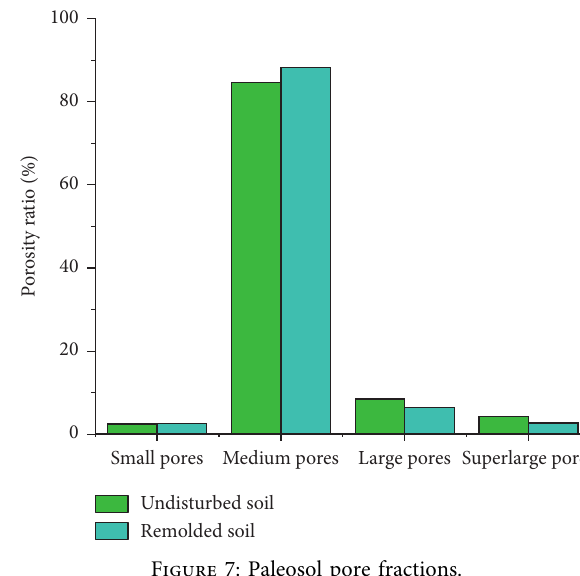
Figure 7: Paleosol pore fractions.